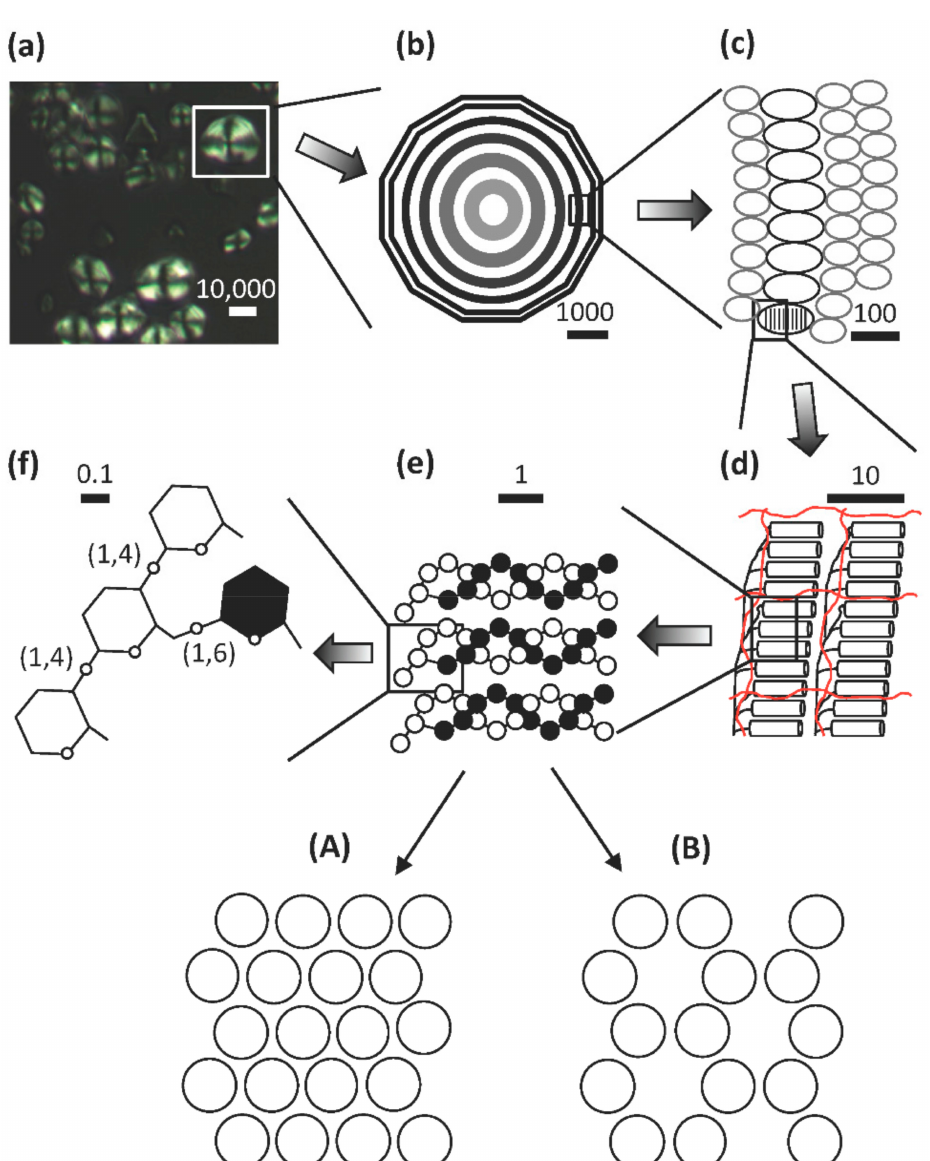
Figure 1. From granules to glucosyl units. ( a ) Maize starch granules observed under polarized light showing the characteristic “Maltese cross”. ( b ) A hypothetical granule with growth rings extending from the hilum. ( c ) Blocklets in semi-crystalline (black) and amorphous (grey) rings. ( d ) Crystalline and amorphous lamellae formed by double helices (cylinders) and branched segments of amylopectin (black lines), respectively. Amylose molecules (red lines) are interspersed among the amylopectin molecules. ( e ) Three double-helices of amylopectin. Each double-helix consists of two polyglucosyl chains, in which the glucosyl units are symbolized by black (A-chains, which are unsubstituted) and white circles (B-chains, which are substituted with other chains), respectively. The double helices form either A- or B-type allomorphic crystals ( A and B , respectively, in which the circles symbolizes the double-helices seen from the edge). ( f ) Glucosyl units showing α -(1,4)- and α -(1,6)-linkages at the base of the double-helix. The bar scale (in nm) is only approximate to give an impression of the size dimensions. Reproduced from [14] with slight